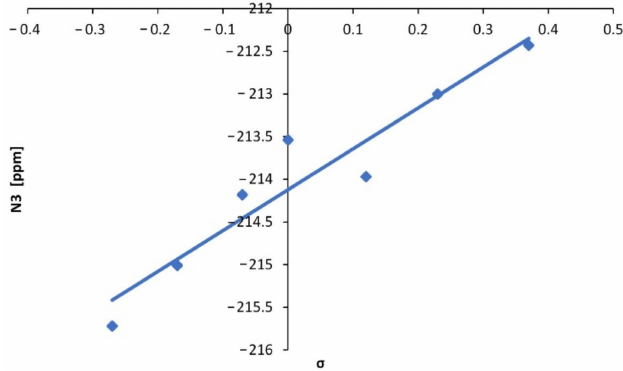
Figure 1. A plot of N3 chemical shift [ppm] vs. Hammett constant for 1 – 8